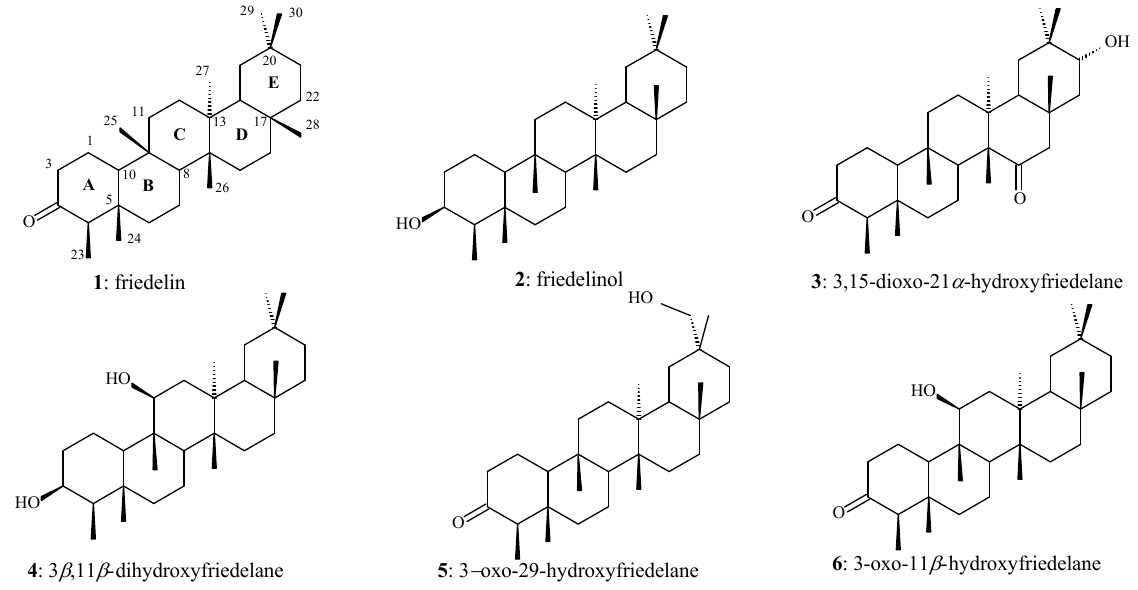
Figure 1. Chemical structure of the triterpenes 1 to 6 previously isolated from the leaves of M. robusta